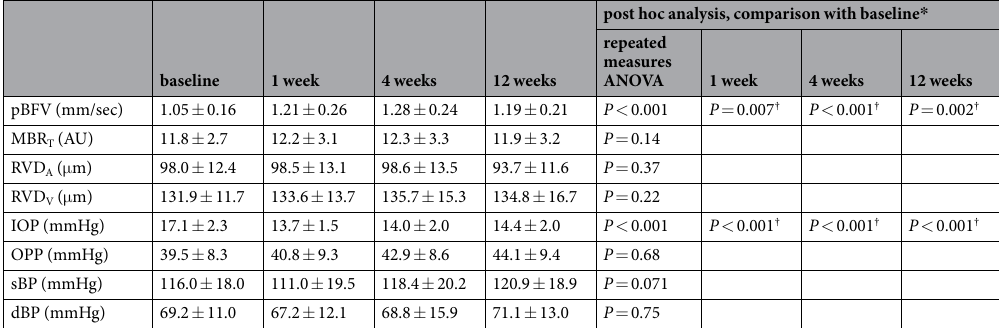
Table 2. Change in each parameter before and after tafluprost initiation. Values comprise mean ± standard deviation. ANOVA = analysis of variance; pBFV = parafoveal retinal blood flow velocity; MBR T = mean blur rate in the tissue area of the optic nerve head; RVD A = retinal vessel diameter of artery; RVD V = retinal vessel diameter of vein; IOP = intraocular pressure; OPP = ocular perfusion pressure; sBP = systolic blood pressure; dBP = diastolic blood pressure. * Comparison was performed using the paired t-test. † Significant differences after Bonferroni’s correction are